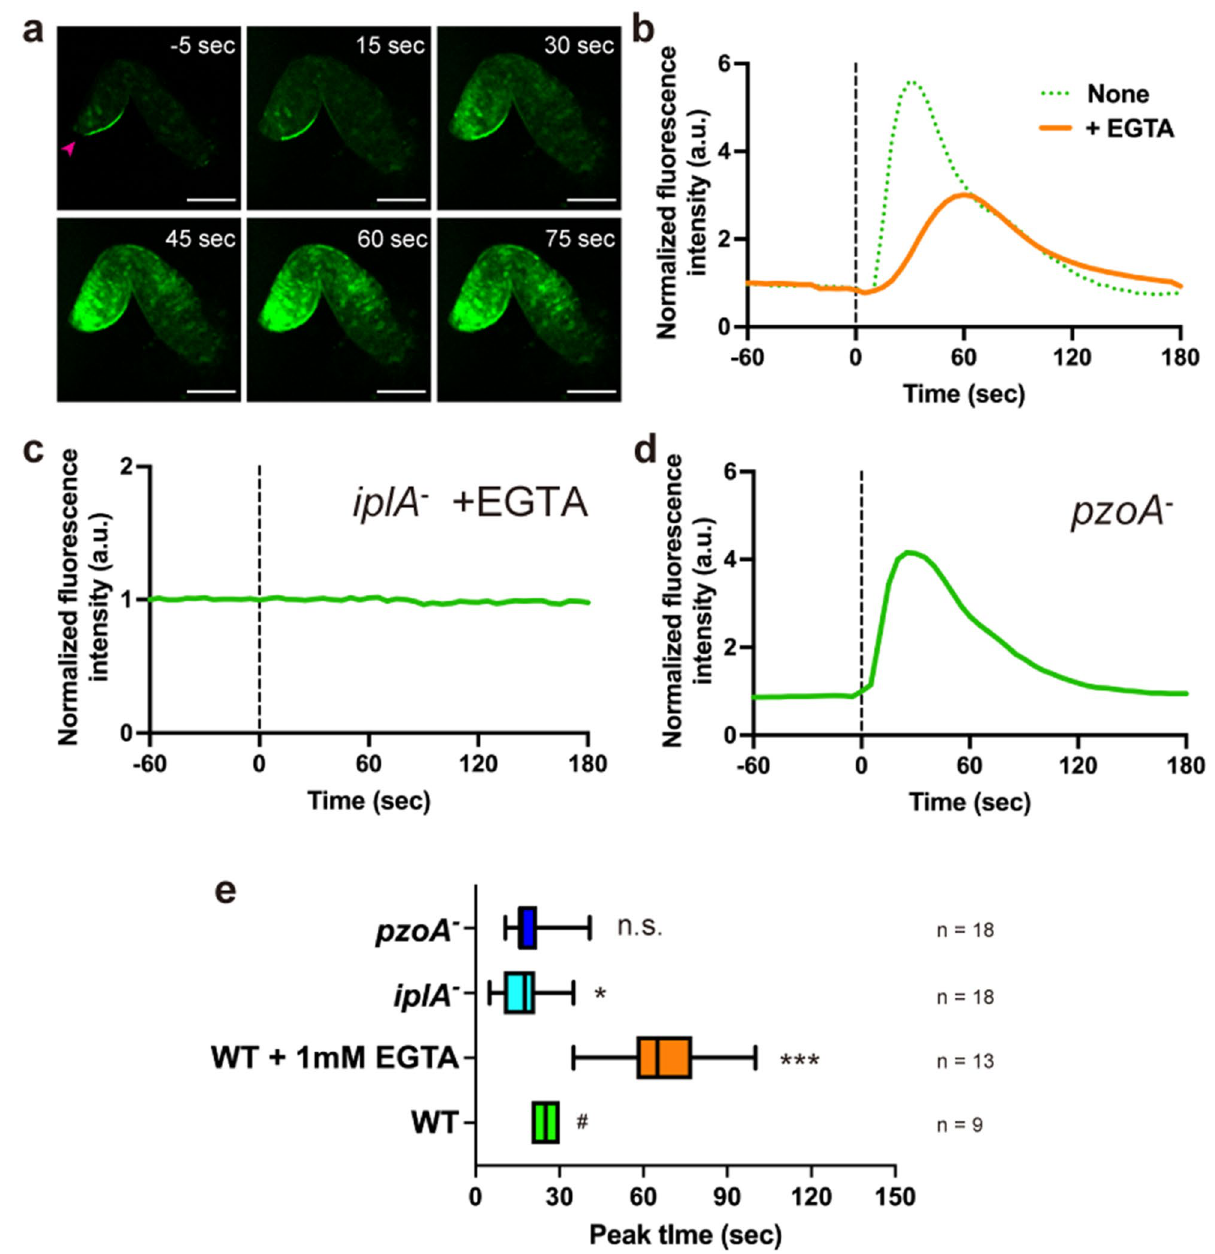
Figure 5. Effect of extracellular Ca 2+ on intracellular Ca 2+ ([Ca 2+ ] i ) bursts in Dictyostelium slugs induced by mechanical stimulation. ( a ) Wild-type slug covered with a piece of agar containing 1 mM aminoethyl ether)- N , N , N ′ , N ′ -tetraacetic acid (EGTA). Representative fluorescence of GCaMP6s in an iplA − slug, mechanically stimulated with a rod on EGTA agar. Magenta arrowhead indicates the anterior of the slug. Scale bar, 100 µm. ( b ) Orange line shows time course of mean fluorescence intensity of GCaMP6s in the 25 µm 2 ROI in the anterior region in A. The green dashed line shows fluorescence intensity in the anterior region in a slug without EGTA in Fig. 3b. ( c ) Time course of mean fluorescence intensity of GCaMP6s in iplA − slugs with agar containing 1 mM EGTA. ( d ) Time course of mean fluorescence intensity of GCaMP6s in PzoA null slugs without 1 mM EGTA. ( e ) Box plots of the peak [Ca 2+ ] i bursts elicited by mechanical stimuli. Lower and upper error bars indicate smallest and largest values, respectively. Average values were compared with the peak time of the wild-type slug without EGTA (#). *, p < 0.05; ***; p < 0.001 (ANOVA with Dunnett’s T3 multiple comparisons test). n.s. indicates no significant